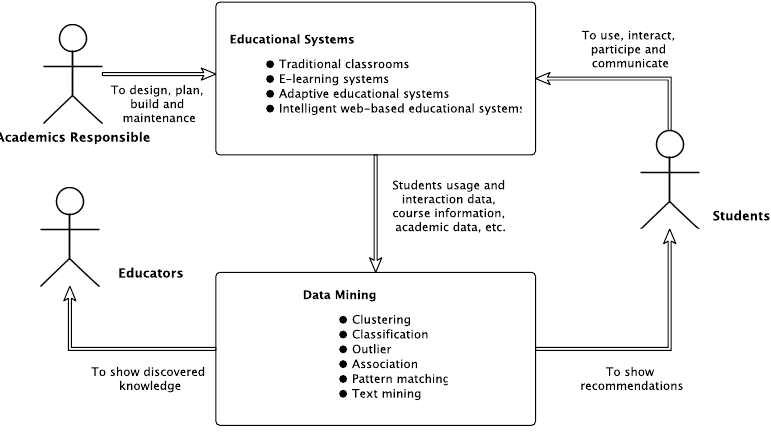
Figure 2. An overview of a unified educational system